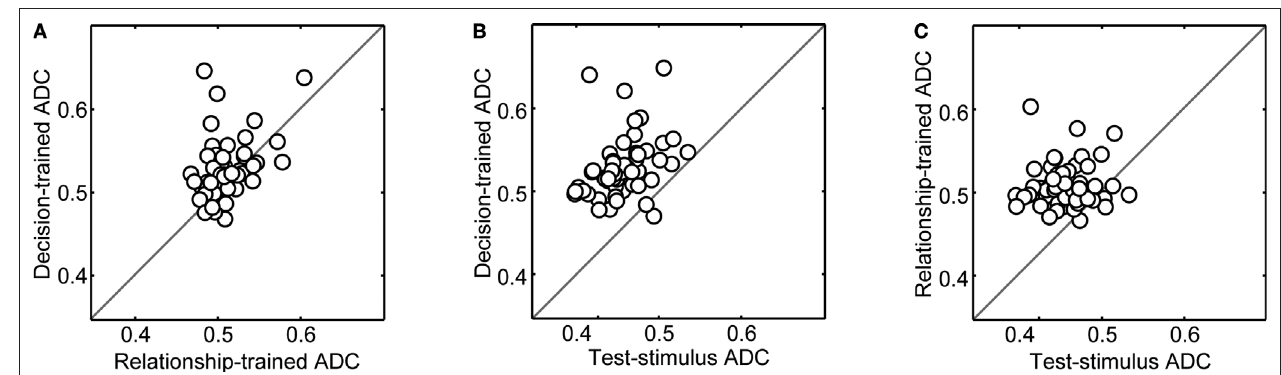
FIGURE 6 | Population analysis of ADC values when the networks were trained using vPFC activity from trials in which the test stimulus was a prototype stimulus only. In each panel, on a neuron-by-neuron basis, two of the three ADC values are compared. In panel (A) , the decision-trained-ADC values